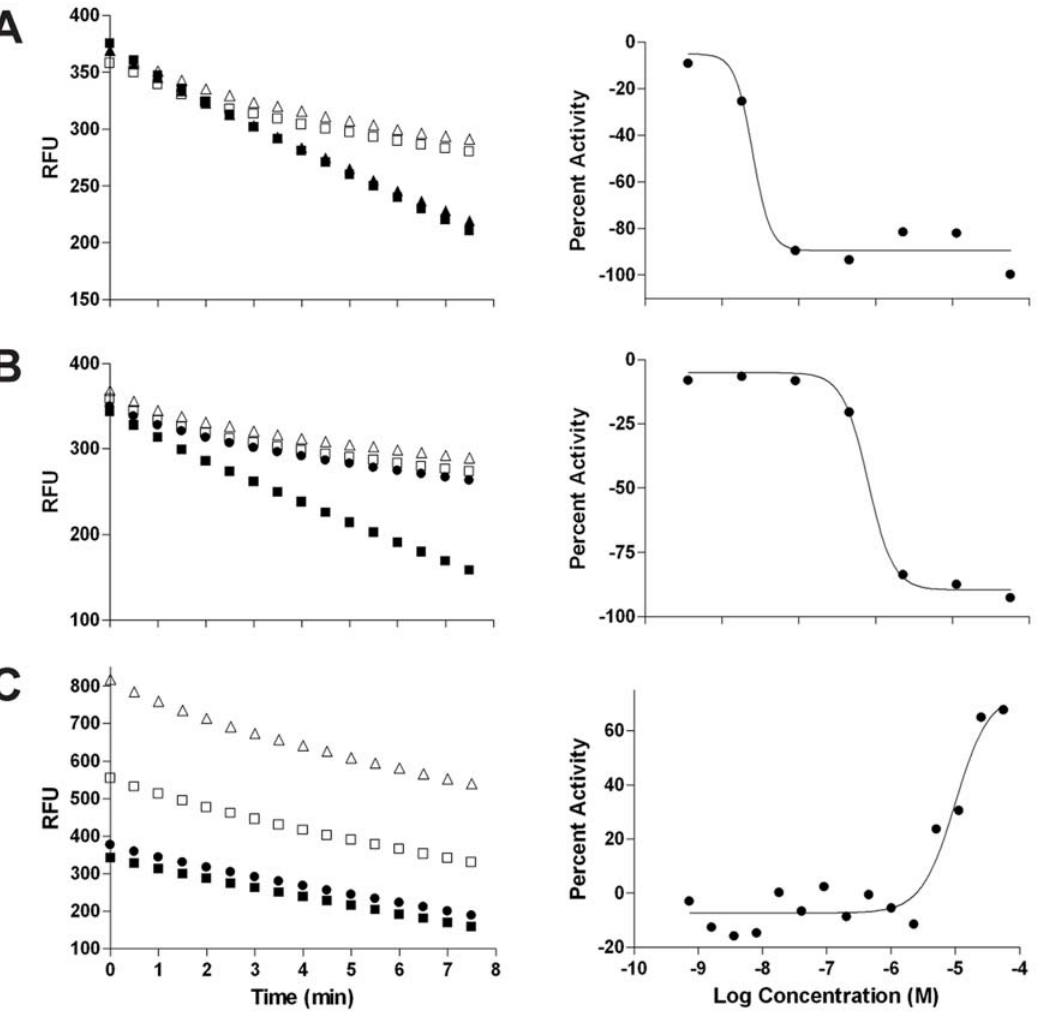
Figure 5. Example time-course plots derived from the primary screen, followed to the right by the corresponding concentration- response curves. (A, B) Non-fluorescent inhibitors, compounds 3 and 14; the decrease in fluorescence is inhibited at increasing compound concentrations while the starting fluorescence remains constant. (C) An example of an apparent activator (Ofloxacin): a highly fluorescent compound which appears to be reacting with one or more components of the assay. Four concentrations out of seven or fifteen are plotted in each of the time course plots for clarity; & , 3.2 nM; m , 16 nM; % , 10 m M; n , 50 m M.